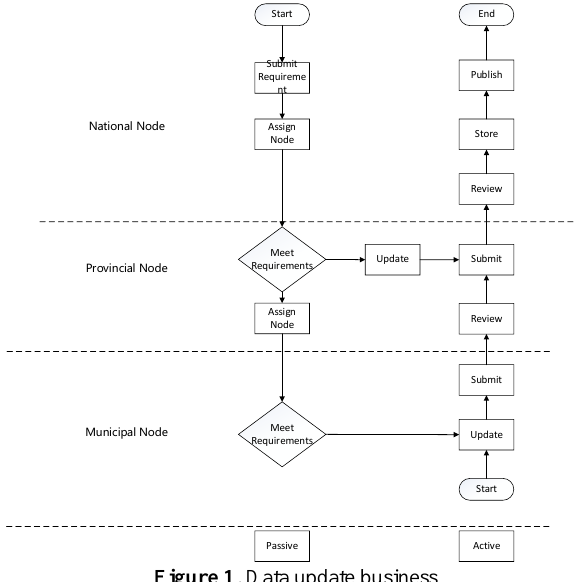
Figure 1 . Data update